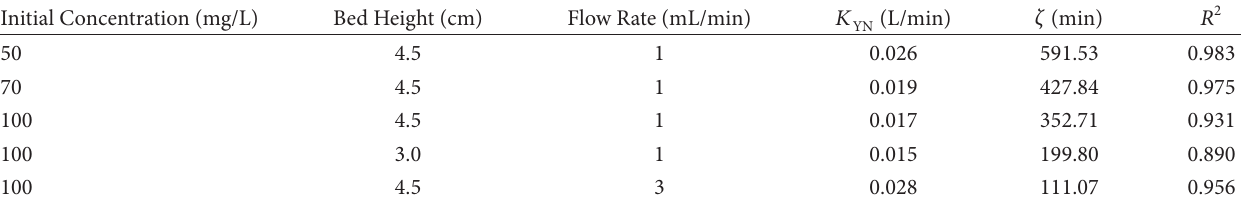
T 4: Yoon-Nelson model parameters for manganese(II) at different conditions using linear regression analysis. Initial Concentration